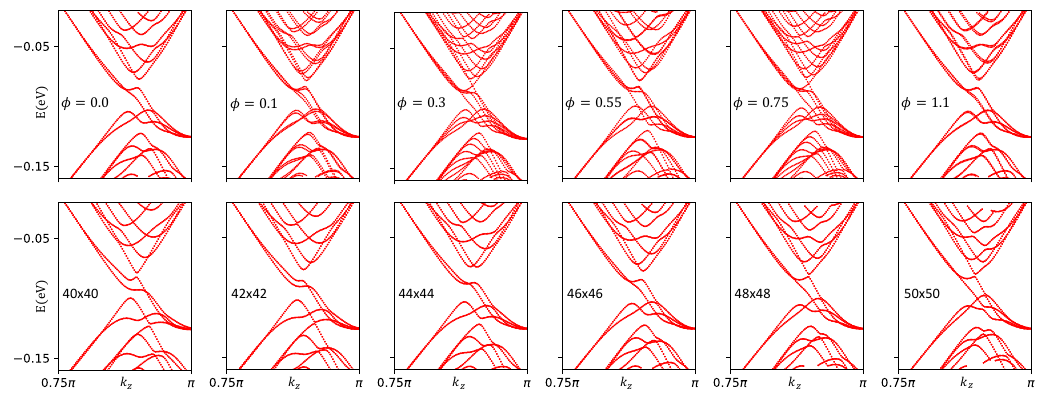
Figure 2: Zoom in on low energy bands in the ( 100 ) wire’s spectra. First row: Gap closing and re-opening under flux, of a 46x46 atoms wire. At zero flux, there are gaps between the surface and hinge bands (although the hinge states are extended to 2D close to the gap, see text). When turning on the flux, the degeneracy is removed. At certain flux values, around φ = 0.3 and φ = 0.7 flux quantum, a gap